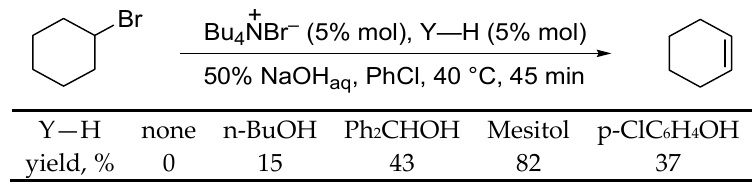
Scheme 19. Search for efficient cocatalyst in PTC β‐ elimination.